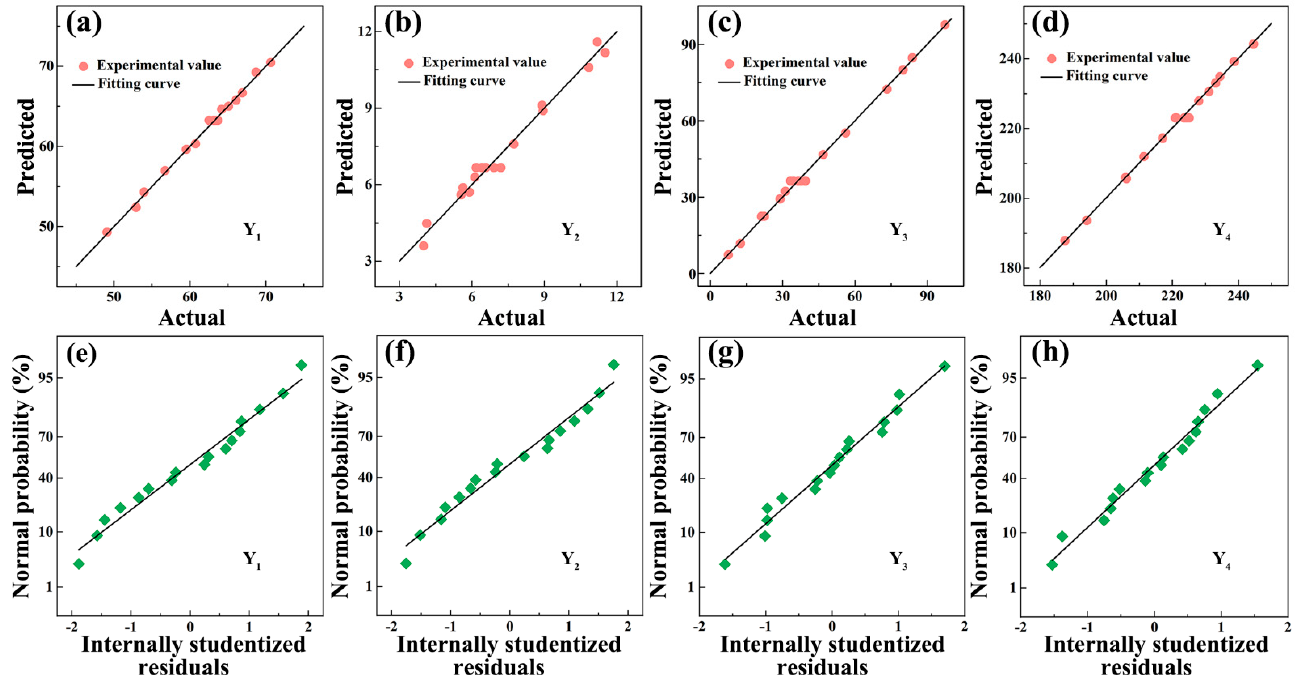
Figure 4. ( a – d ) Regression graphs of the experimental and predicted values: ( a ) Y 1 , ( b ) Y 2 , ( c ) Y 3 , and ( d ) Y 4 . ( e – h ) Normal probability plots of studentized residuals: ( e ) Y 1 , ( f ) Y 2 , ( g ) Y 3 , and ( h ) Y 4 .